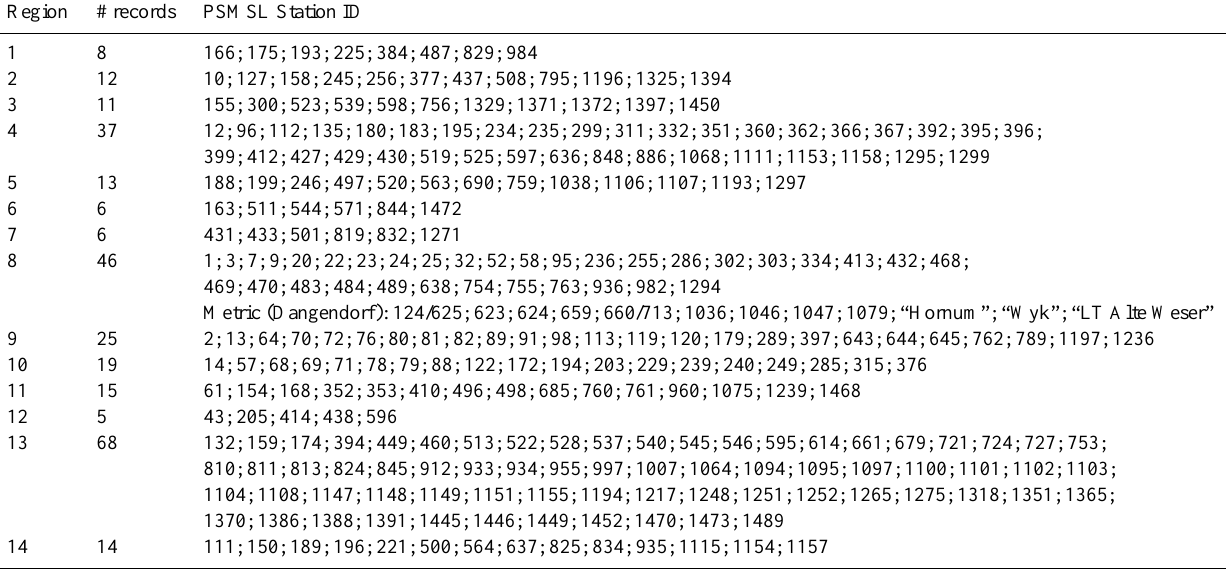
Table 1. Station codes of 285 tide gauge stations (RLR) included in the analysis (Holgate et al., 2013, http://www.psmsl.org). Region